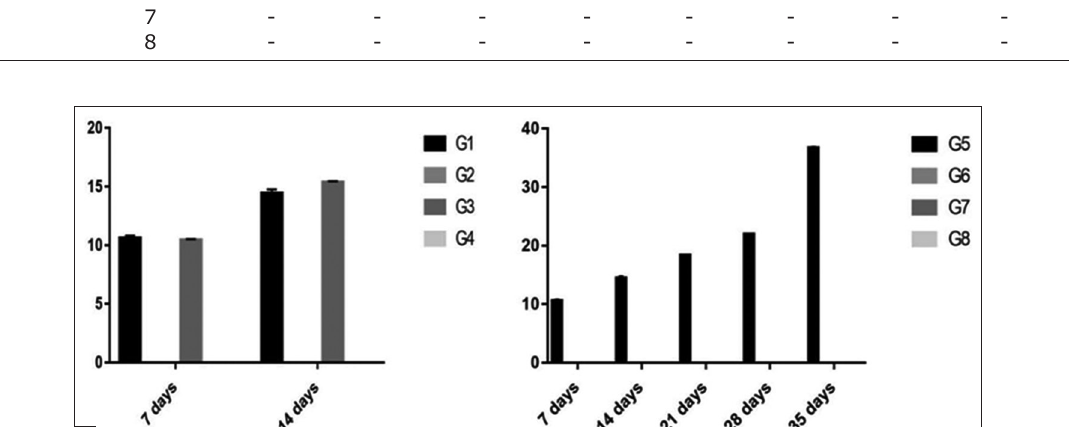
a Figure-3: Column chart showing serum ELISA titer of infectious bronchitis coronavirus (expressed as ELISA units). (a) Experiment 1, (b) Experiment 2.